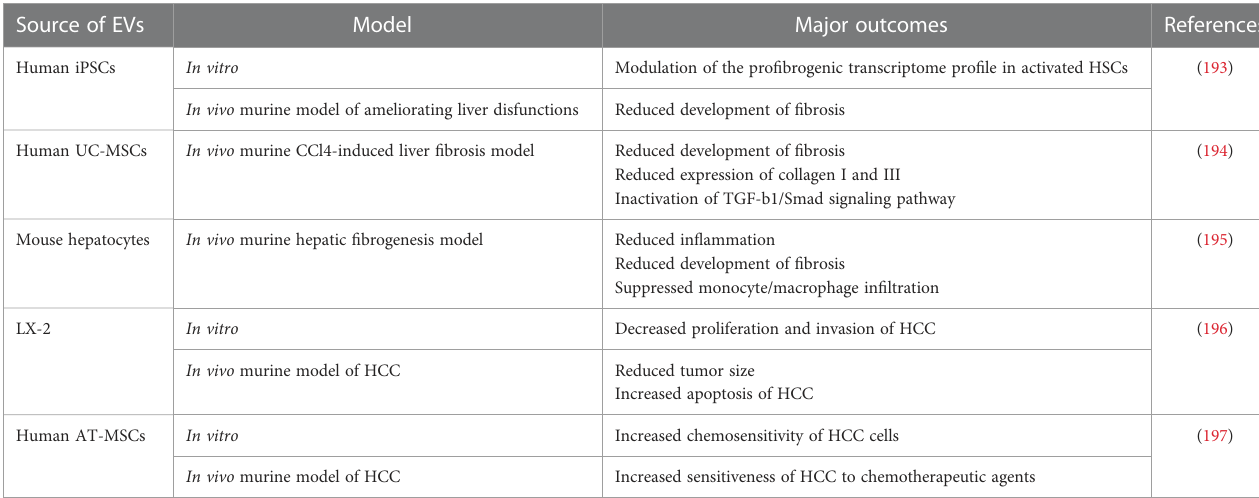
TABLE 4 Examples of EV use in preclinical studies related to the treatment of liver dysfunctions. Source of